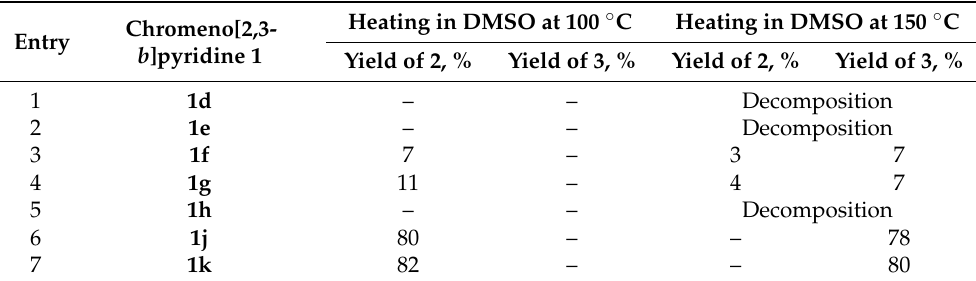
Figure 2. Other 5-(2-hydroxy-6-oxocyclohexyl)-5 H -chromeno[2,3- b ]pyridines 1 studied as objects of thermal rearrangement. Table 3. Verification of the generality of the thermal rearrangement of chromeno[2,3- b ]pyridines 1 with other substituents 1,2